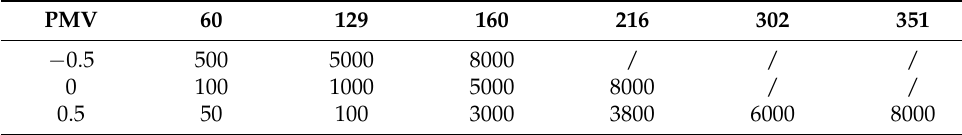
Table 5. Air-supply volume under different passenger-capacity conditions Q (m 3